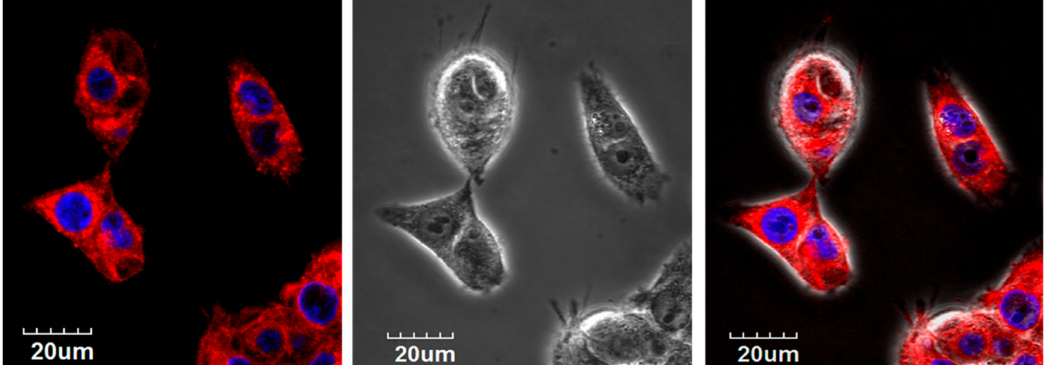
Figure 3. Confocal microscopy on live Cal 27 cells L to R: fluorescent, bright field, and merged images. The top row shows internalization of 4Iphf-HN17-Cy5 (red) into cytosol. Red: 4phlf-HN17-Cy5; Blue: Hoechst 33,342 stained